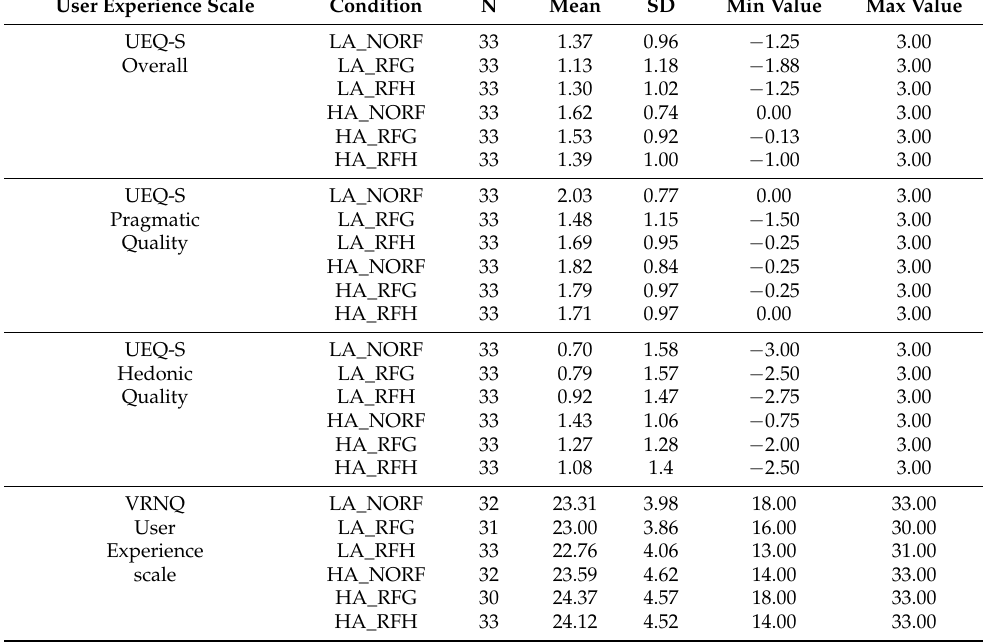
Table 5. Subjective user experience levels assessed by the short version of the User Experience Questionnaire (UEQ-S) and VRNQ (User Experience Section)